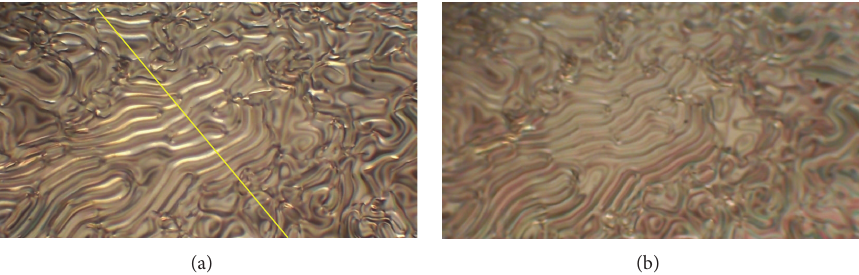
Figure 7: Visual appearance of fingerprint structure before (a) and after (b) the injection of ethanol.